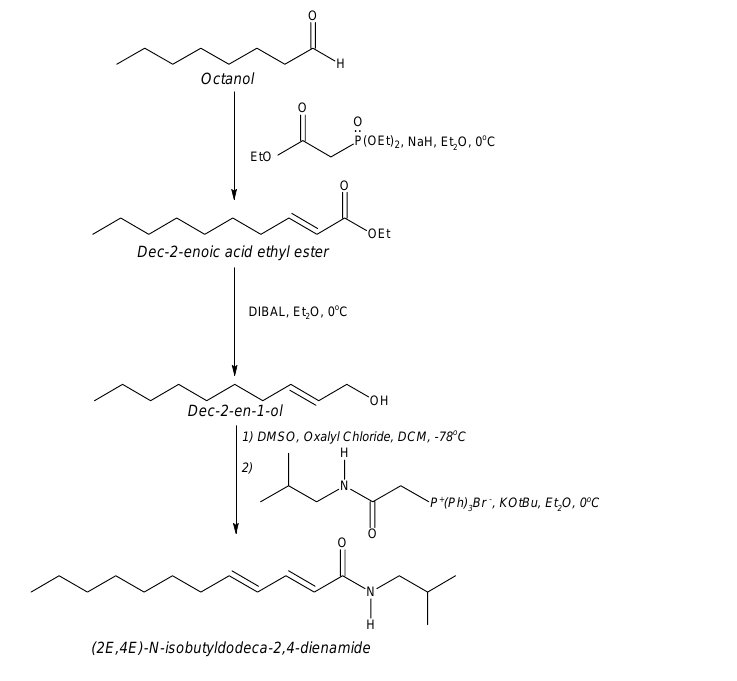
Figure 2: Novel synthetic pathway for (2 E ,4 E )- N -isobutyldodeca-2,4-dienamide mw = 251 ( 5 ).